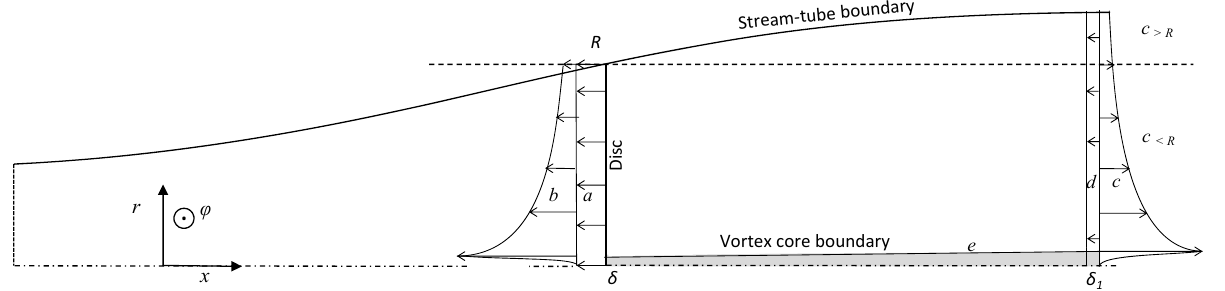
Figure 1. Pressure distributions acting in the momentum balance. The arrows give the direction of the pressure fields acting on the flow. The meaning of a , b , c, d and e is given in Sect.